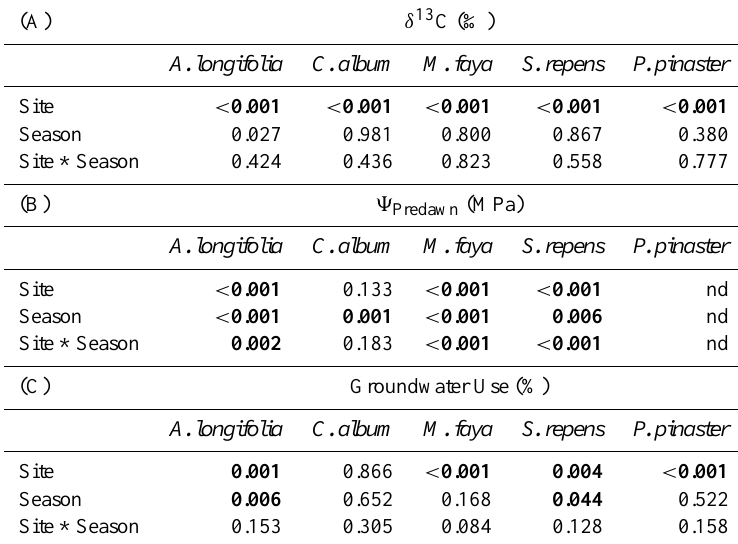
Table 1. P-values from Analysis of Variance with (A) bulk leaf δ 13 C, (B) predawn xylem water potential ( 9 pre ) and (C) groundwater use as response variables and Site, Season and the Site*Season interaction as predictor variables. ANOVA was conducted for each species and response variable independently. Groundwater use data were square root transformed before analysis to satisfy the ANOVA assumptions of normality and homogeneity of variance. Significant values ( α = 0 . 05) are shown in bold.